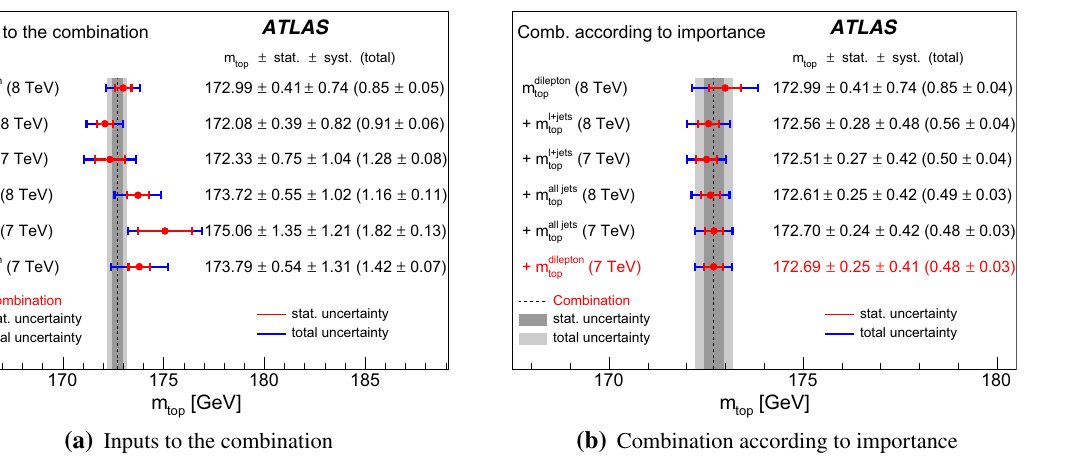
the uncertainty in the total uncertainty. In this figure, each line shows the combined result when adding the result listed to the combination indicated by a ‘+’. The new ATLAS combination is given in the last line, and shown in both figures as the vertical grey bands